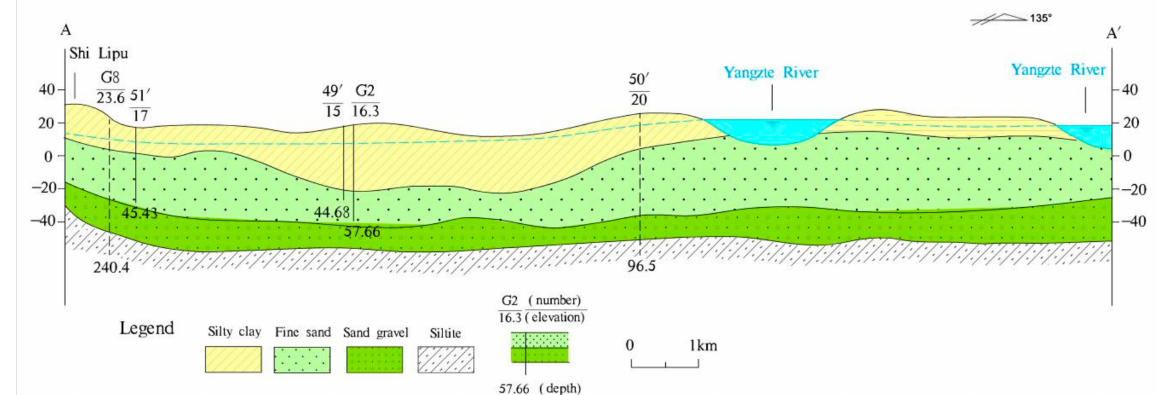
Figure 2. Hydrogeologic cross sections along the A–A’ transect in Figure 1.